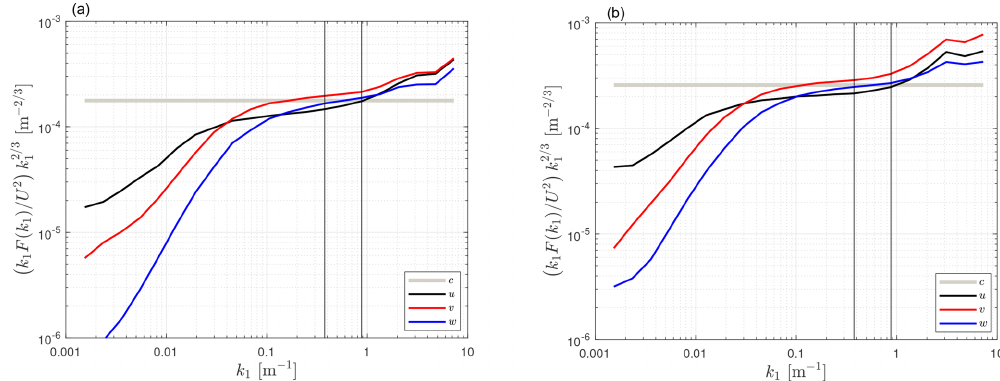
Figure 8. Similar to Fig. 3 but for the CSAT3 at the Nørrekær Enge wind farm.